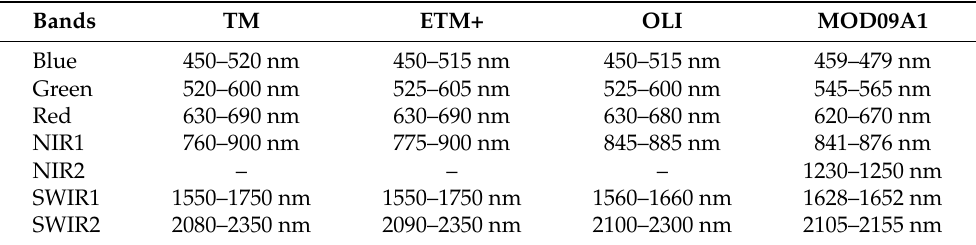
Table 3. Spectral wavelengths covered by different sensors. Bands of the sensors Thematic Mapper (TM) [66], Enhanced Thematic Mapper Plus (ETM+) [67], Operational Land Imager (OLI) [67] and the Moderate Resolution Imaging Spectroradiometer (MODIS) product MOD09A1 [56] are compared. Bands in the visible Red-Green-Blue (RGB), Near Infrared (NIR) and Short Wavelength Infrared (SWIR) wavelength areas are listed. Bands TM ETM+ OLI